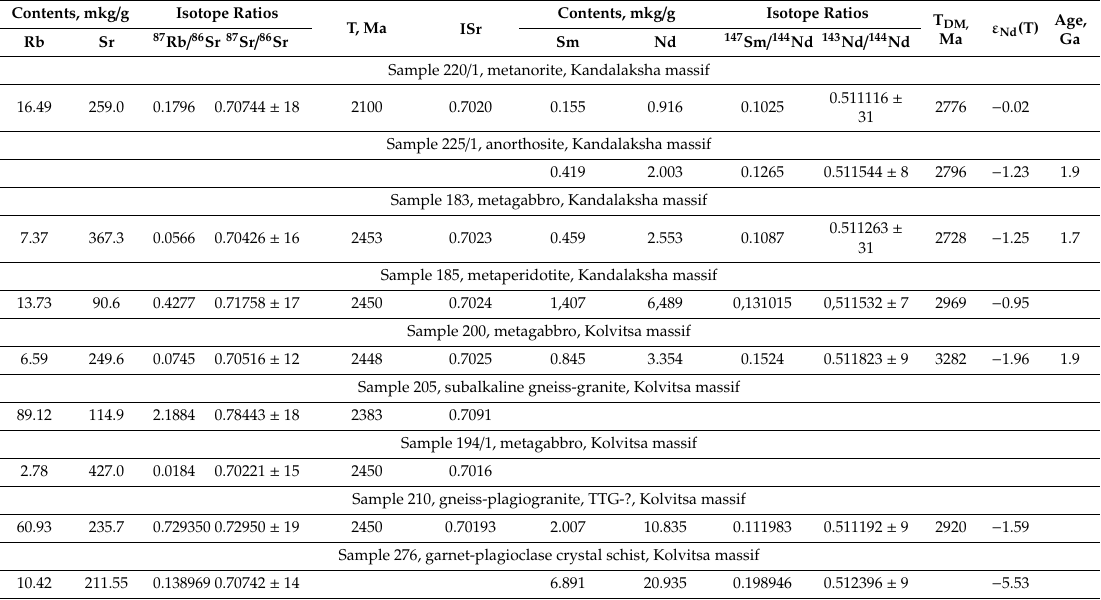
Figure 9. Variations of ε Nd and Isr in rocks of layered Proterozoic intrusions in the Baltic Shield [45–47]. Table 5. Results of the Nd–Sr isotope analysis of rocks from the Kolvitsa and Kandalaksha